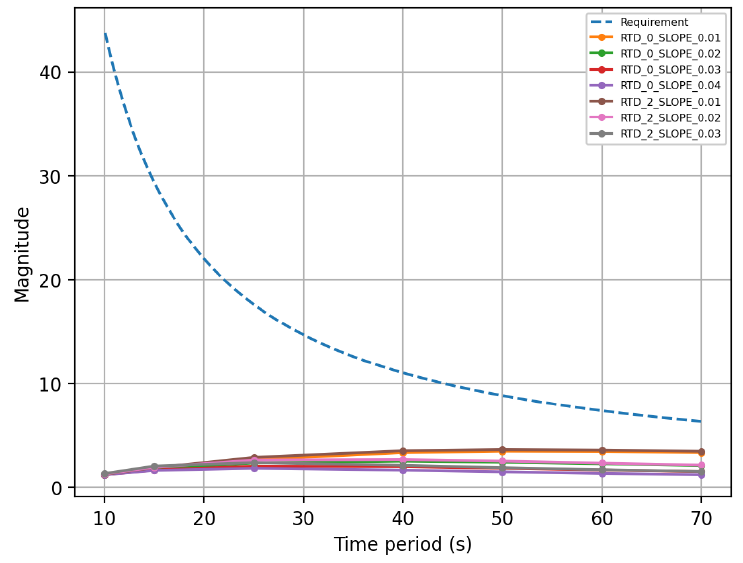
Figure 15. Aggregated plots showing the impact of injected latency and slope of the ramp controller to FCR dynamic